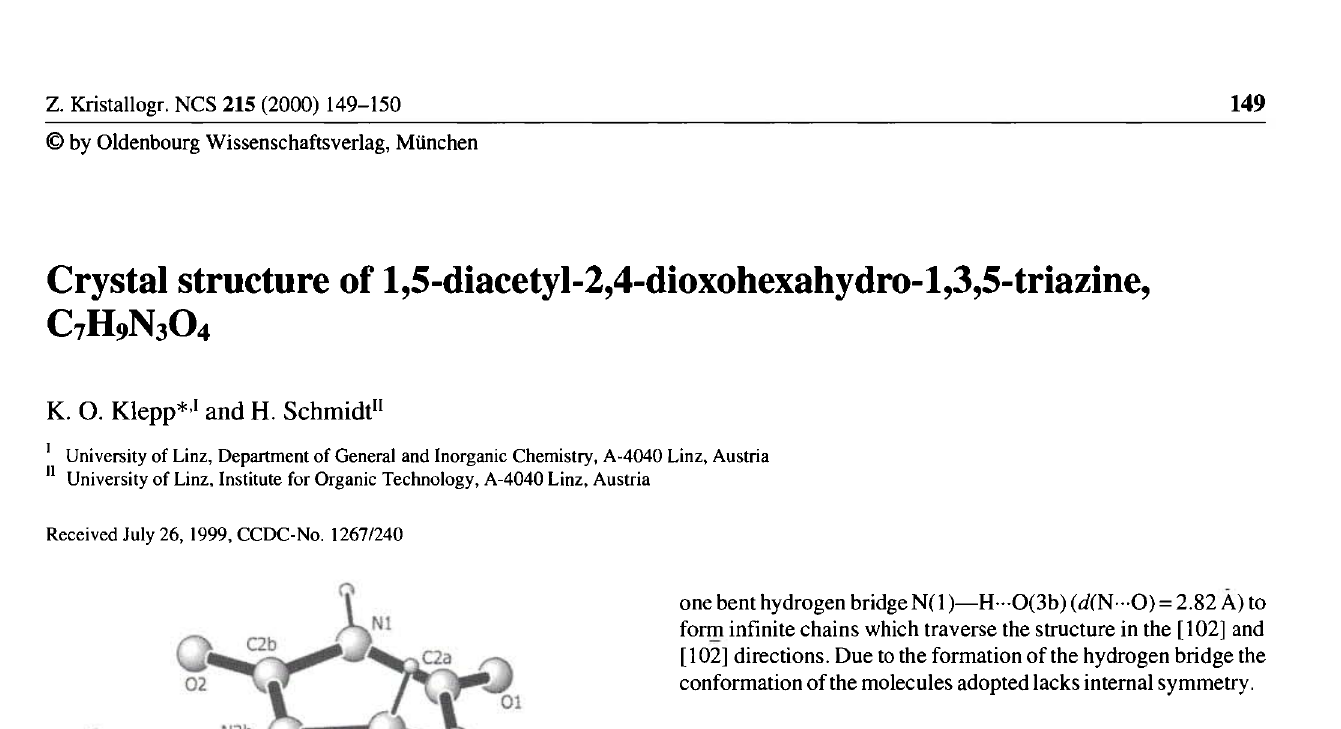
Table 1. Data collection and handling. Crystal: